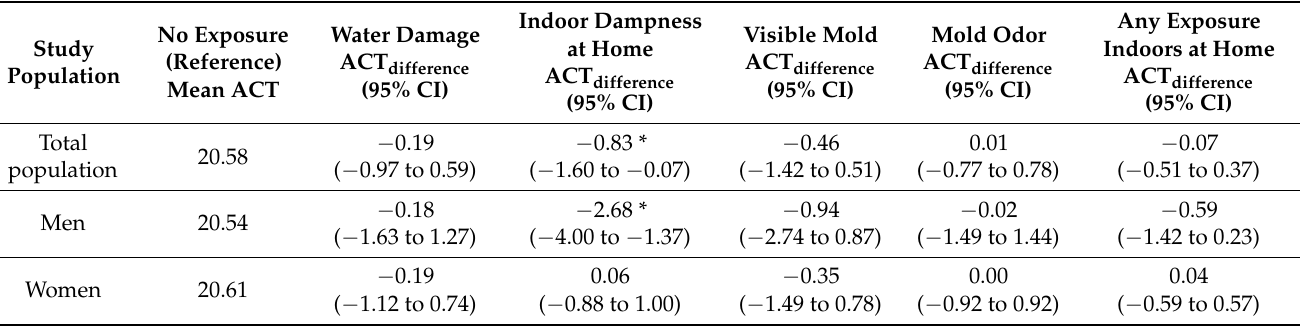
Table 2. Residential dampness and mold exposures and the adjusted difference in the ACT score (95% confidence interval) in comparison to no indoor dampness or mold exposure at home. The Northern Finnish Asthma Study